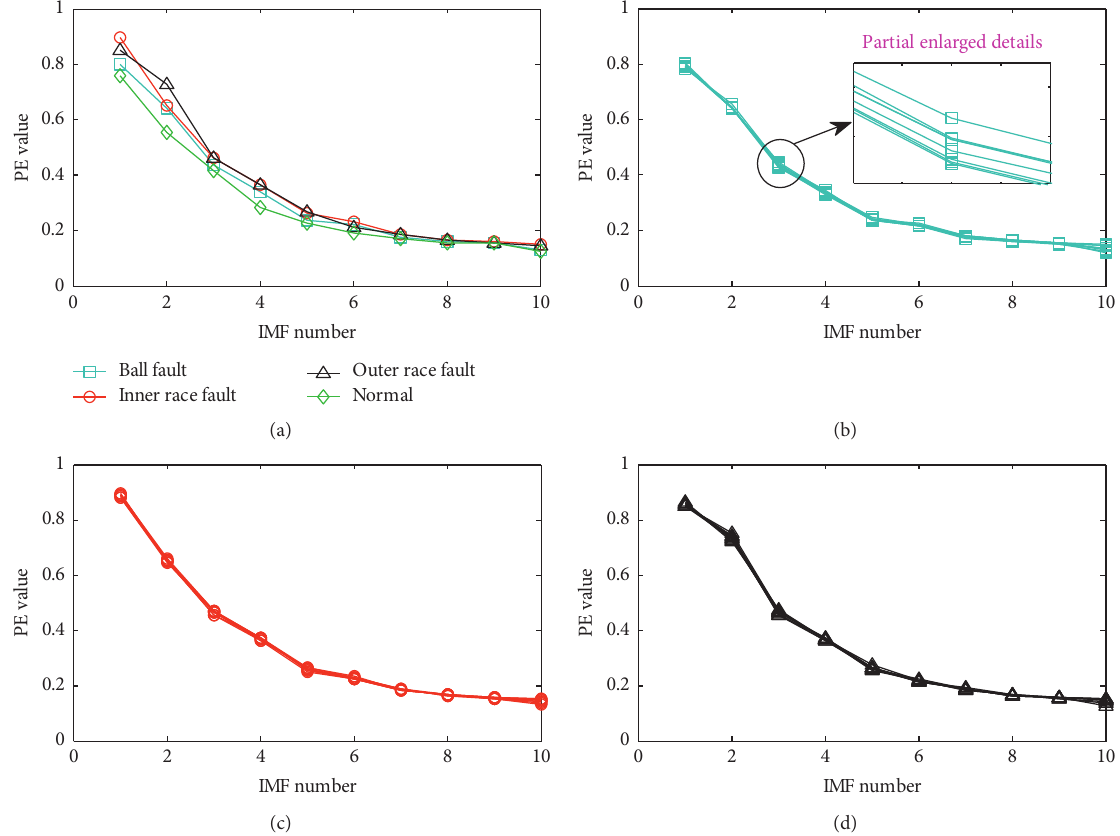
Figure 6: The distribution patterns of PE on different IMF components. (a) The average PE values of each IMF component of different fault conditions. (b) 8 samples of ball fault. (c) 8 samples of inner race fault. (d) 8 samples of outer race fault.